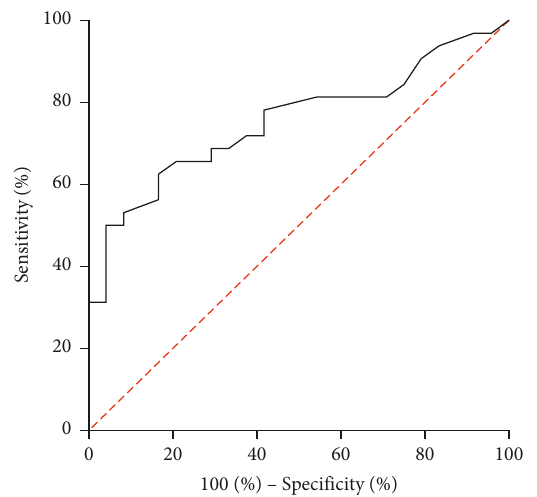
Figure 1: ROC curve analysis of systolic blood pressure elevation during pneumoperitoneum creation predicting the hypertensive spike. The sensitivity was 62.5% and specificity was 83.3% when systolic blood pressure increased > 22.5mmHg from baseline